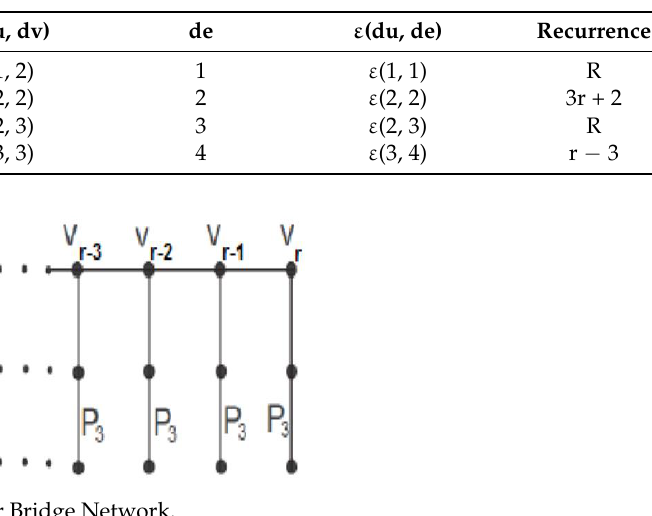
Table 2. Edge partition of G r (P s, v ) over P s .